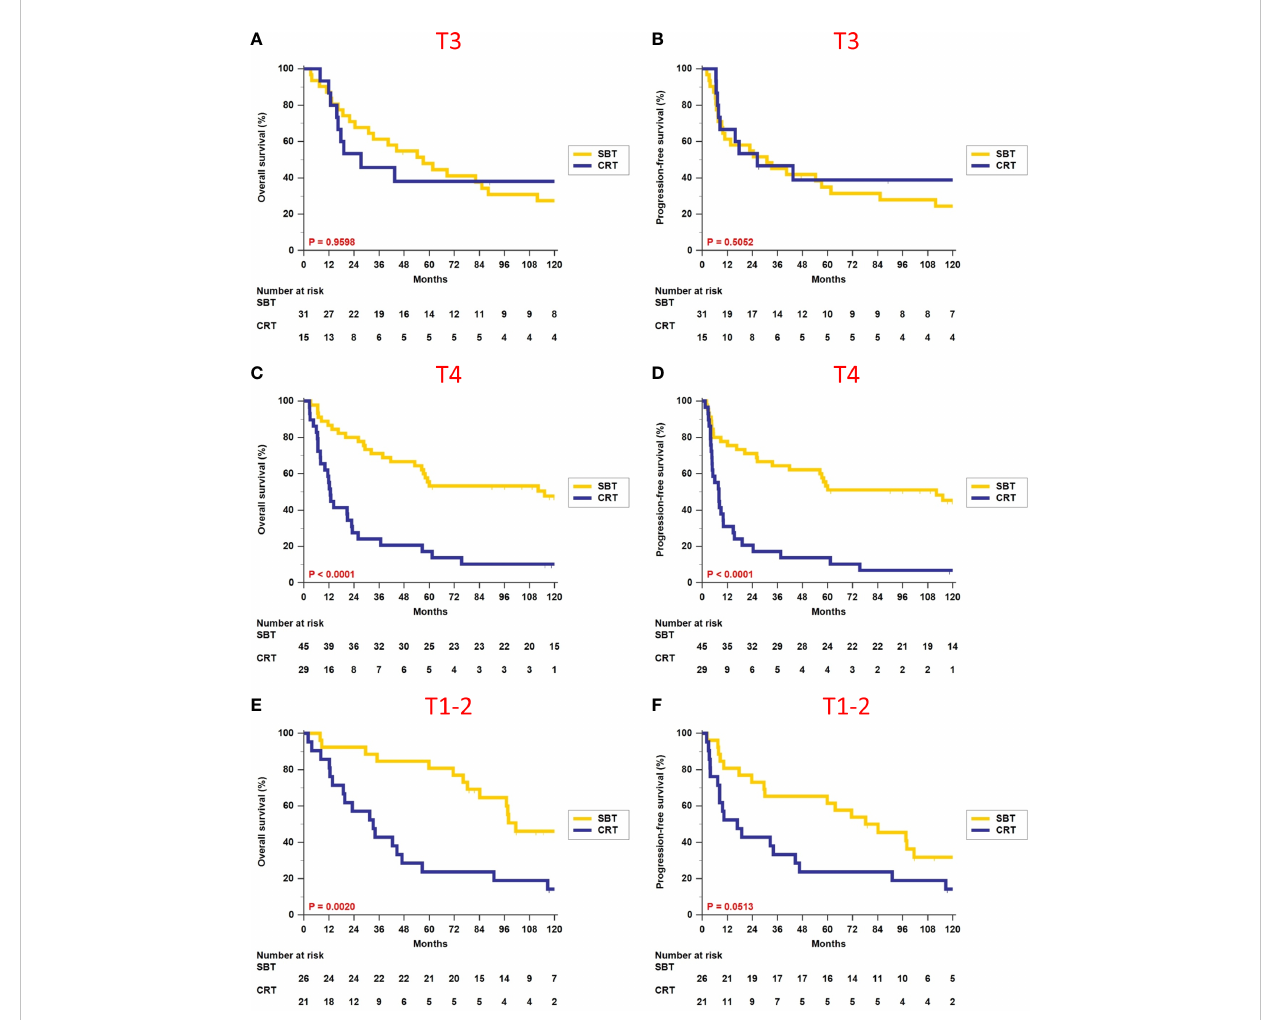
FIGURE 2 Comparison of overall survival and progression-free survival between surgery-based therapy (SBT) and de fi nitive chemoradiotherapy (CRT) for the T1 – 2, T3, and T4